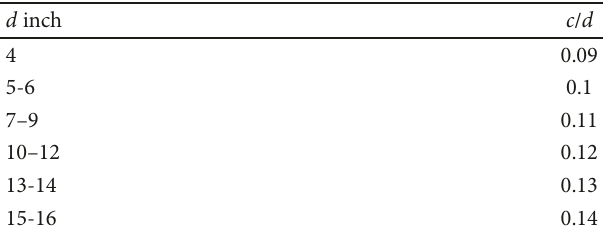
Table 2: Estimated c/d ratio for k calculation.